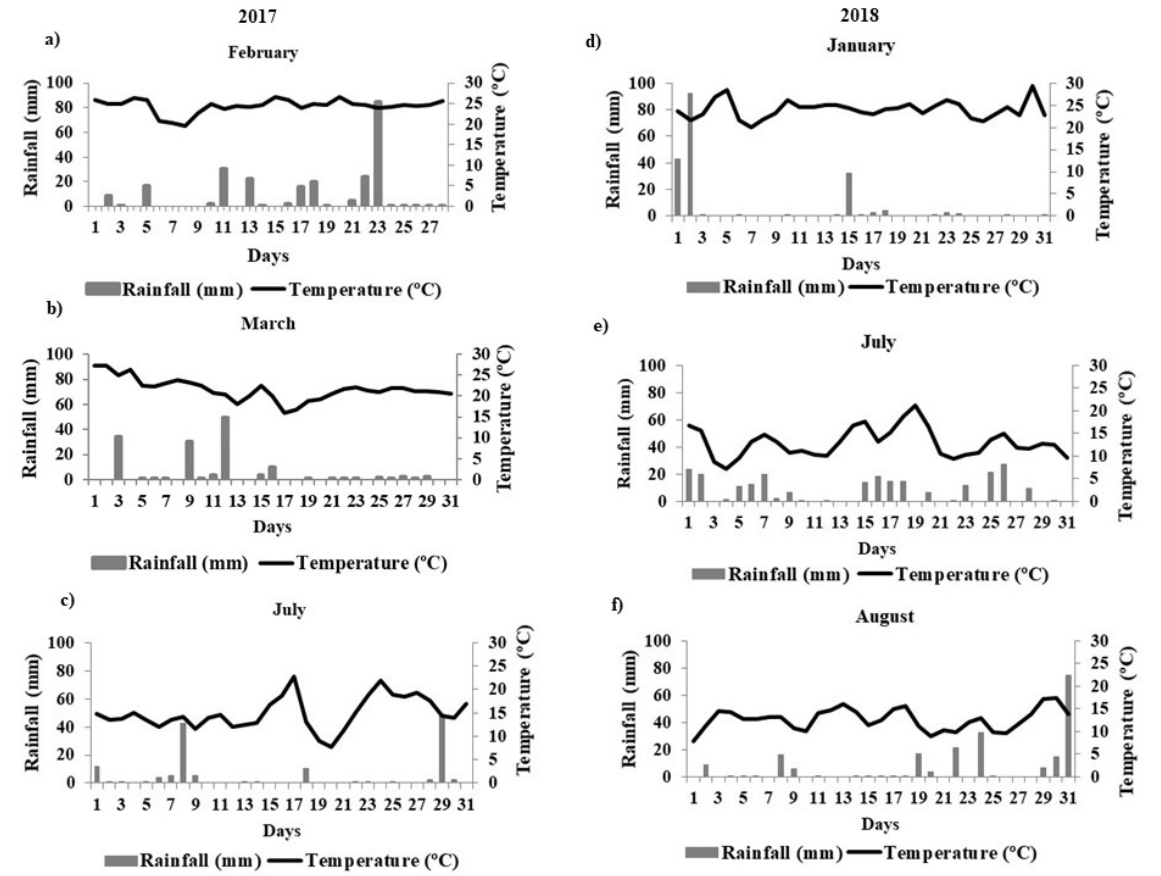
Figure 1. Precipitation, and temperature in Pelotas, RS, Brazil.a) February 2017; b) March 2017; c) July 2017;